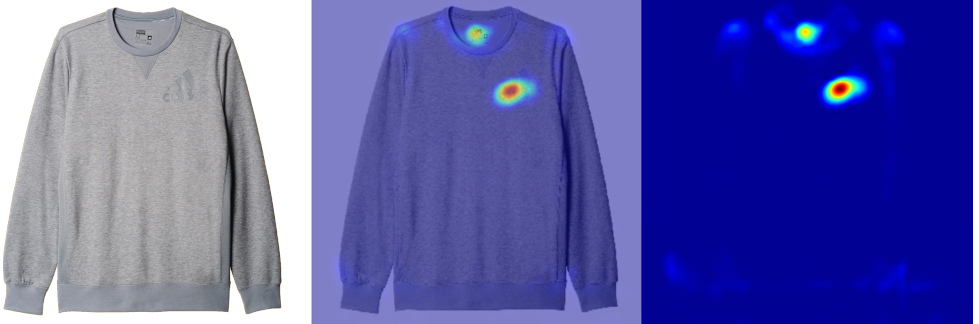
Figure 7. Heatmap of a nearly invisible medium